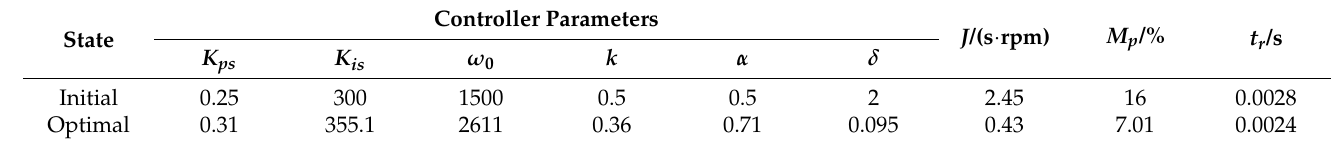
Figure 13. Pareto front for objective optimization of speed loop. Table 3. Optimized controller parameters and their objective values of the speed loop.